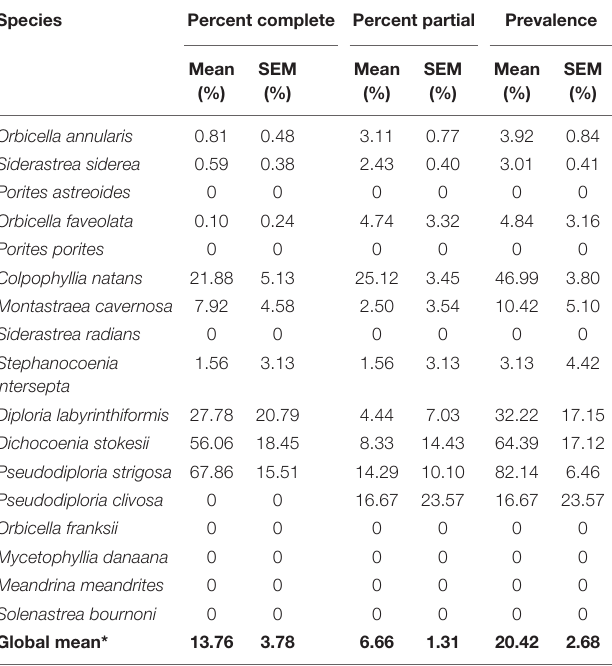
TABLE 1 | The number of colonies analyzed per species for 2017 and 2019 plots, as well as the number of colonies which experienced complete or partial mortality during the same period. Species are ranked by their total abundance.